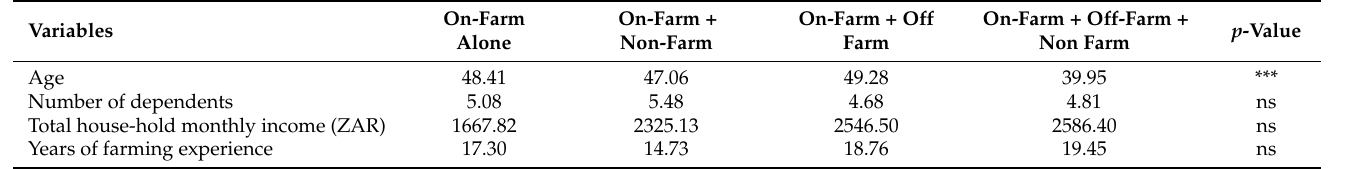
Table 5. Table 5. Parametric one-Way ANOVA results for irrigation farmworkers’ livelihood-diversification strategies.